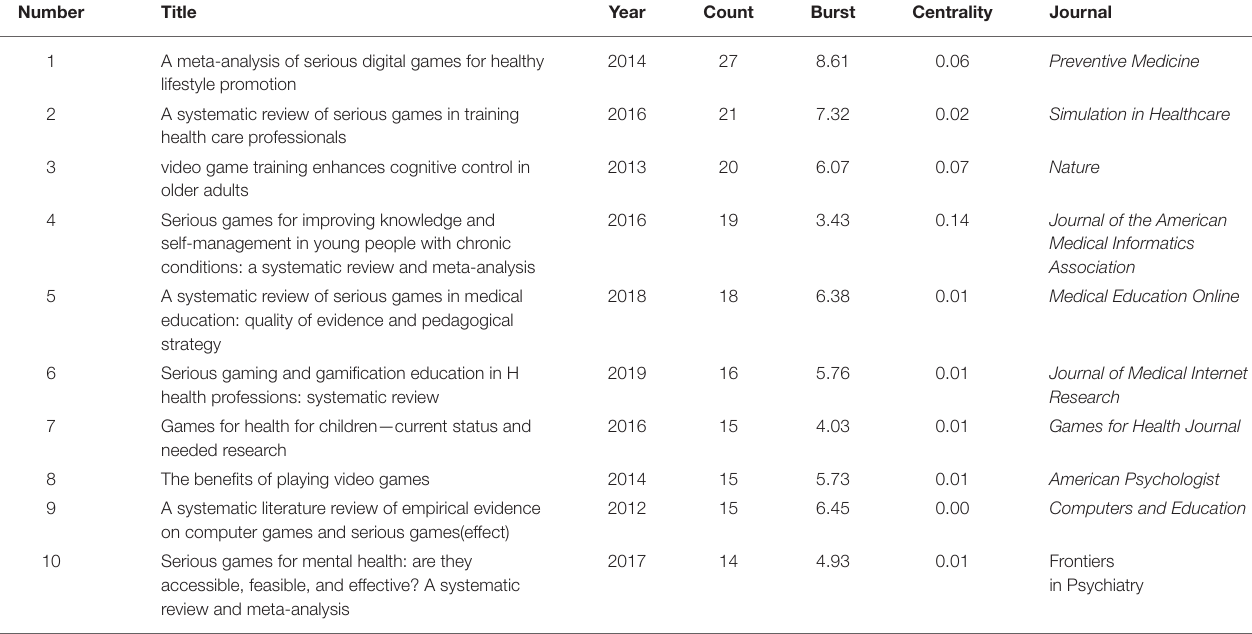
TABLE 4 | The top 10 cited